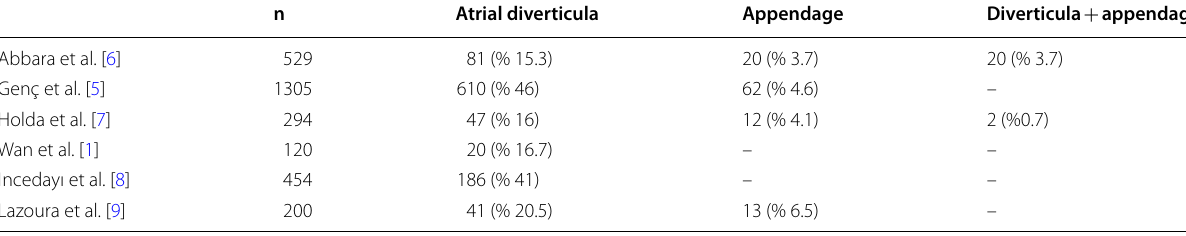
Table 3 Rates of atrial diverticulum, accessory appendage and its association in different studies n